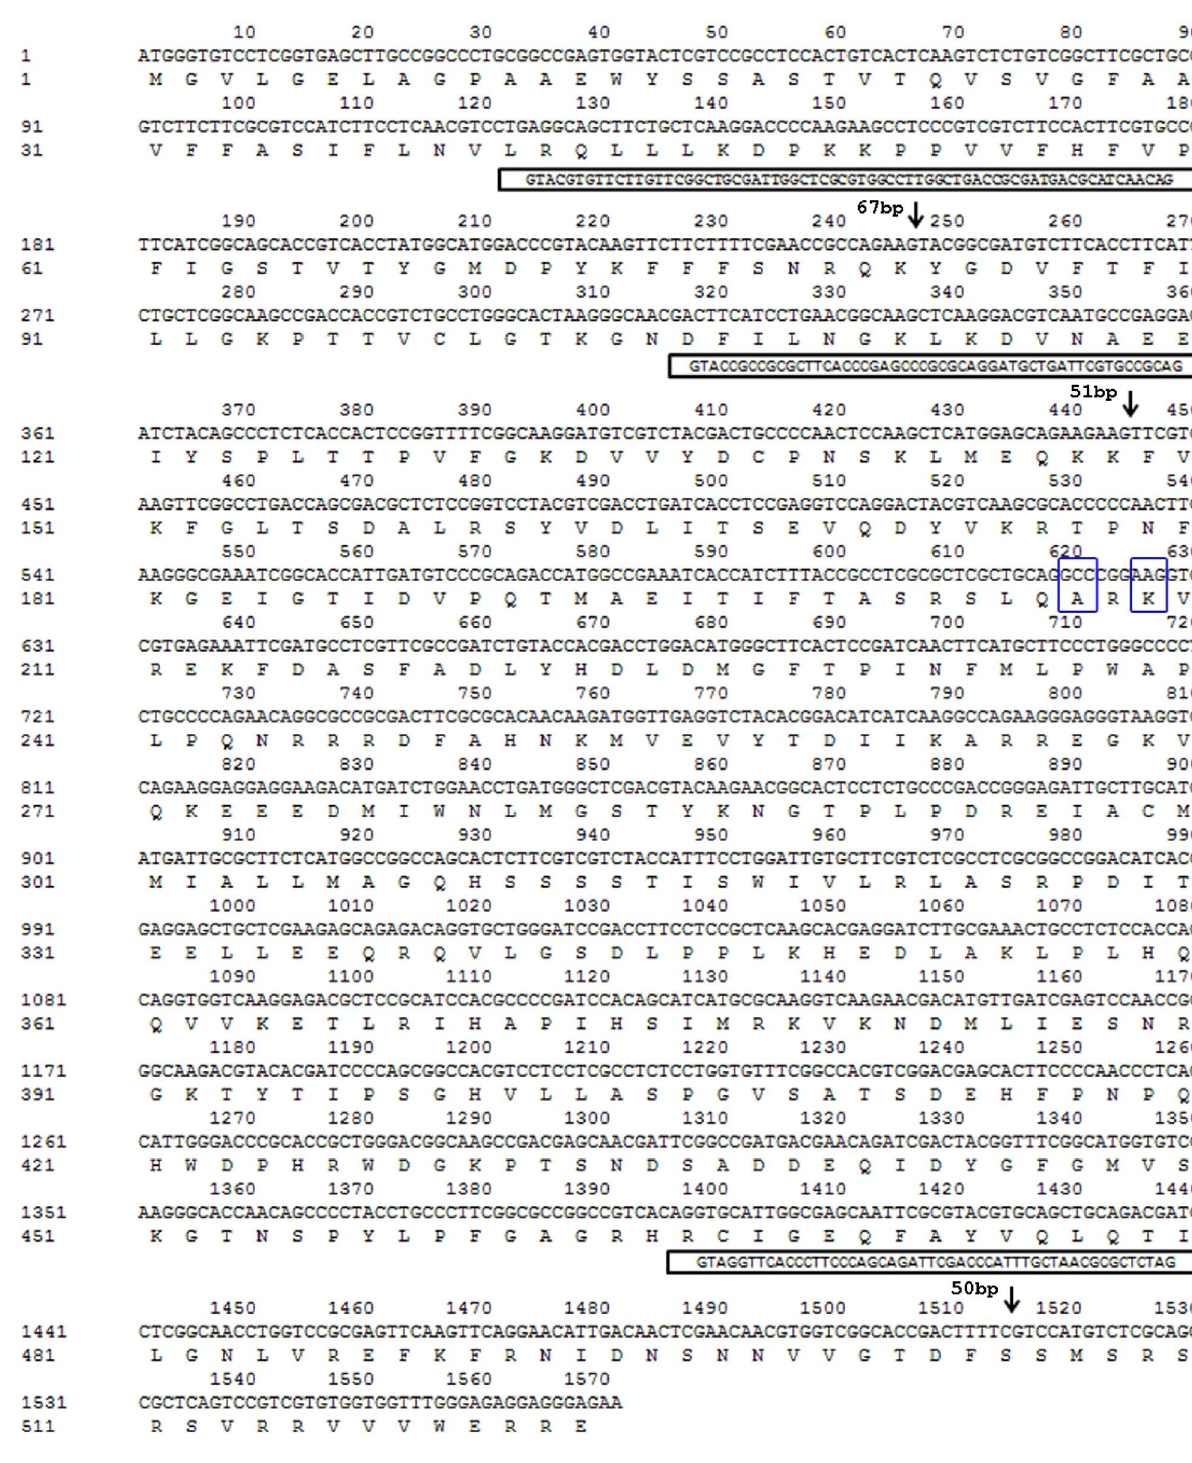
Figure 4. Partial sequences and deduced amino acid sequences of the LtCYP51 gene from sensitive Lasiodiplodia theobromae isolates YC70 (Accession number: MZ365052).The intron sequence is depicted in a solid line box with an arrow showing the insertion site. Two amino acid substitutions were found at position 207 and 209 (in blue